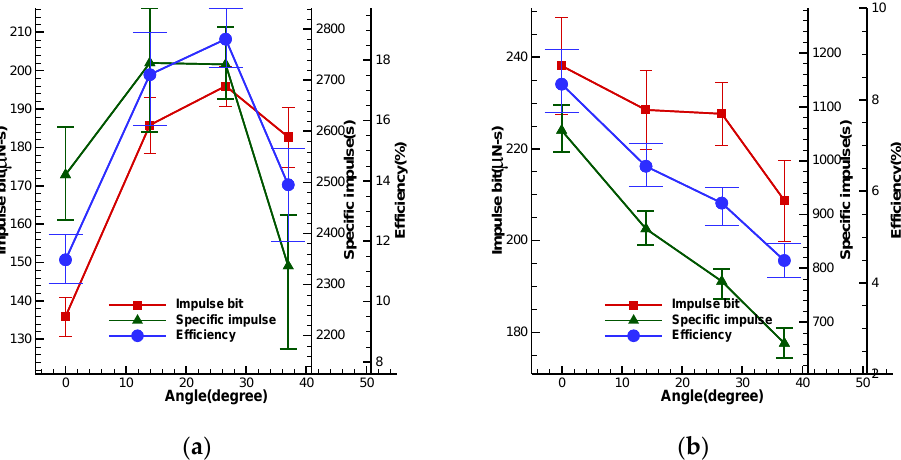
Figure 9. The APPT performance of rectangular electrodes with variable flare angles: ( a ) the electrode spacing is 3 mm and ( b ) the electrode spacing is 25 mm.